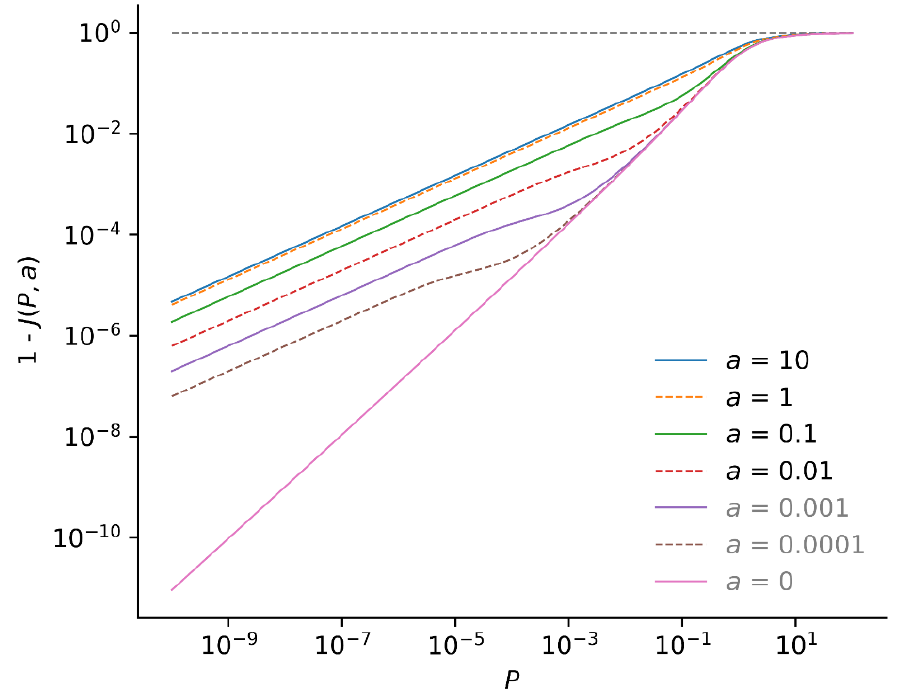
Figure 1. Dependence of the expression (1 – J ( P , a )), where J is given by Equation (16) on the variable P for various values of a which is the Lorentz-to-Doppler width ratio in the Voigt spectral line shape.